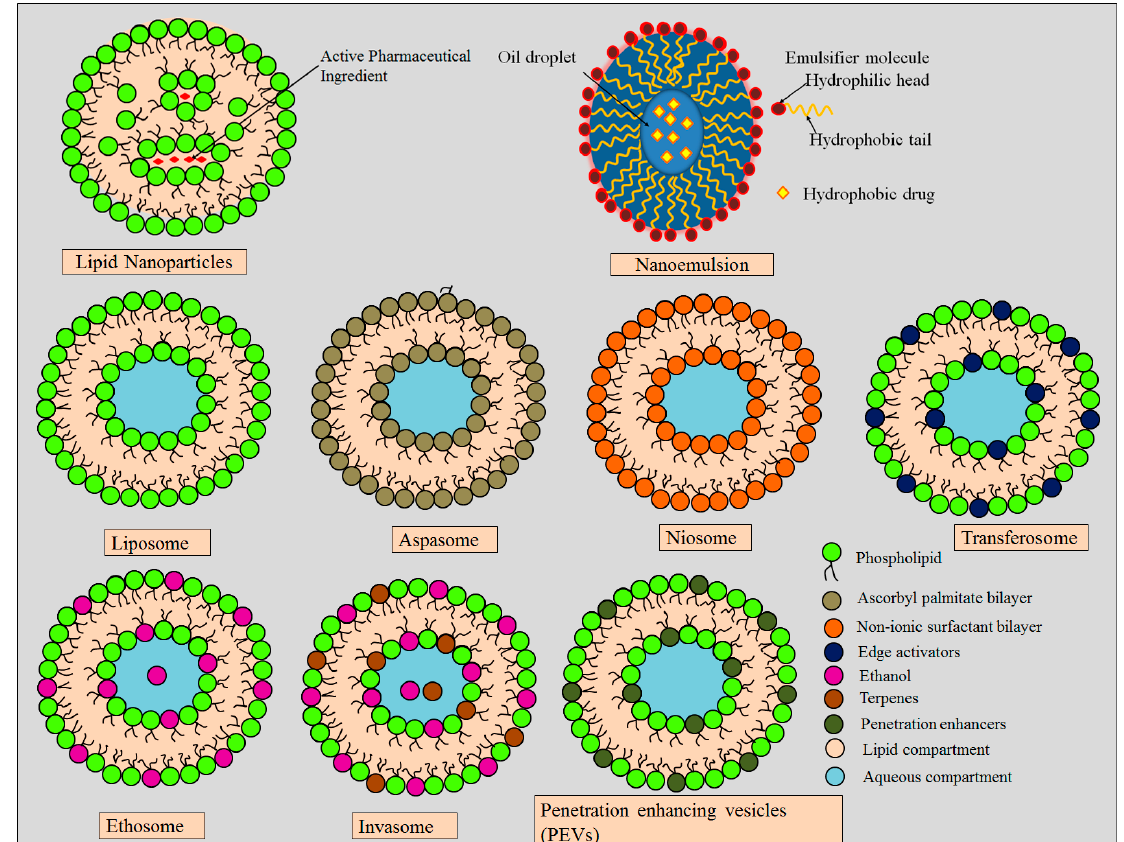
Figure 3. Structural representation of various lipid based nanocarriers.